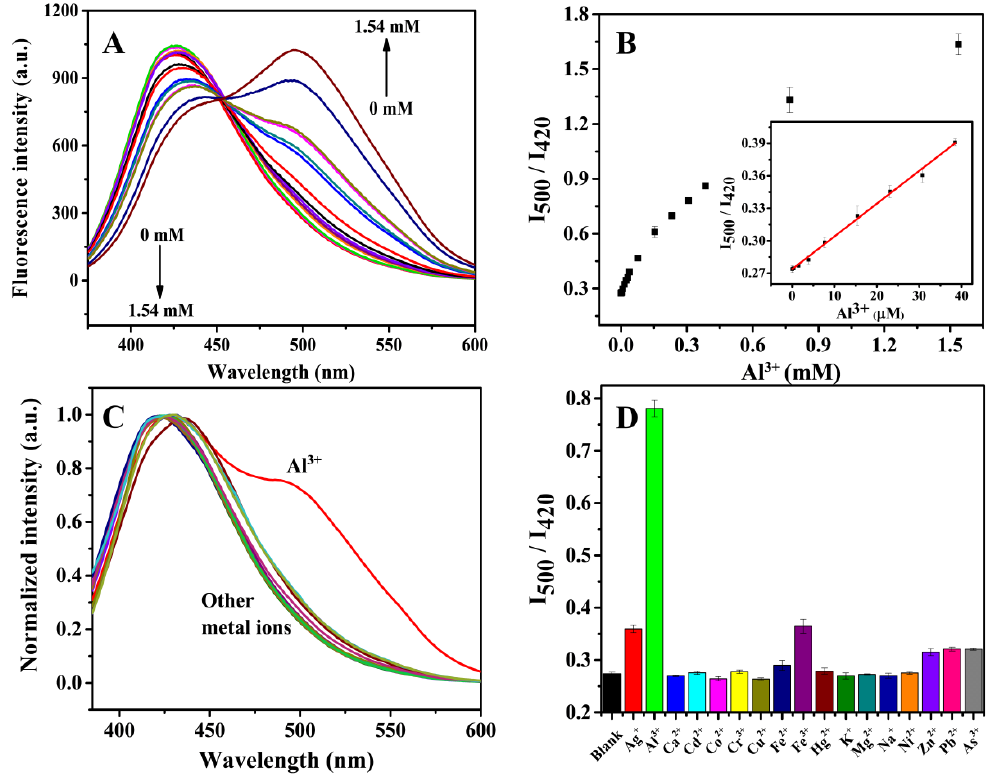
Figure 3. ( A ) Fluorescence spectra of the CDs upon the addition of different concentrations of Al 3+ ; ( B ) relation between the concentration of Al 3+ and the I 500 /I 420 value. The inset shows the linear relation in the 0.15–38.46 μM range; ( C ) fluorescence spectra and ( D ) I 500 /I 420 variation of the CDs upon the addition of 307.69 μM different metal ions (Ag + , Al 3+ , Ca 2+ , Cd 2+ , Co 2+ , Cr 3+ , Cu 2+ , Fe 2+ , Fe 3+ , Hg 2+ , K + , Mg 2+ , Na + , Ni 2+ , Zn 2+ , Pb 2+ , and As 3+ ).